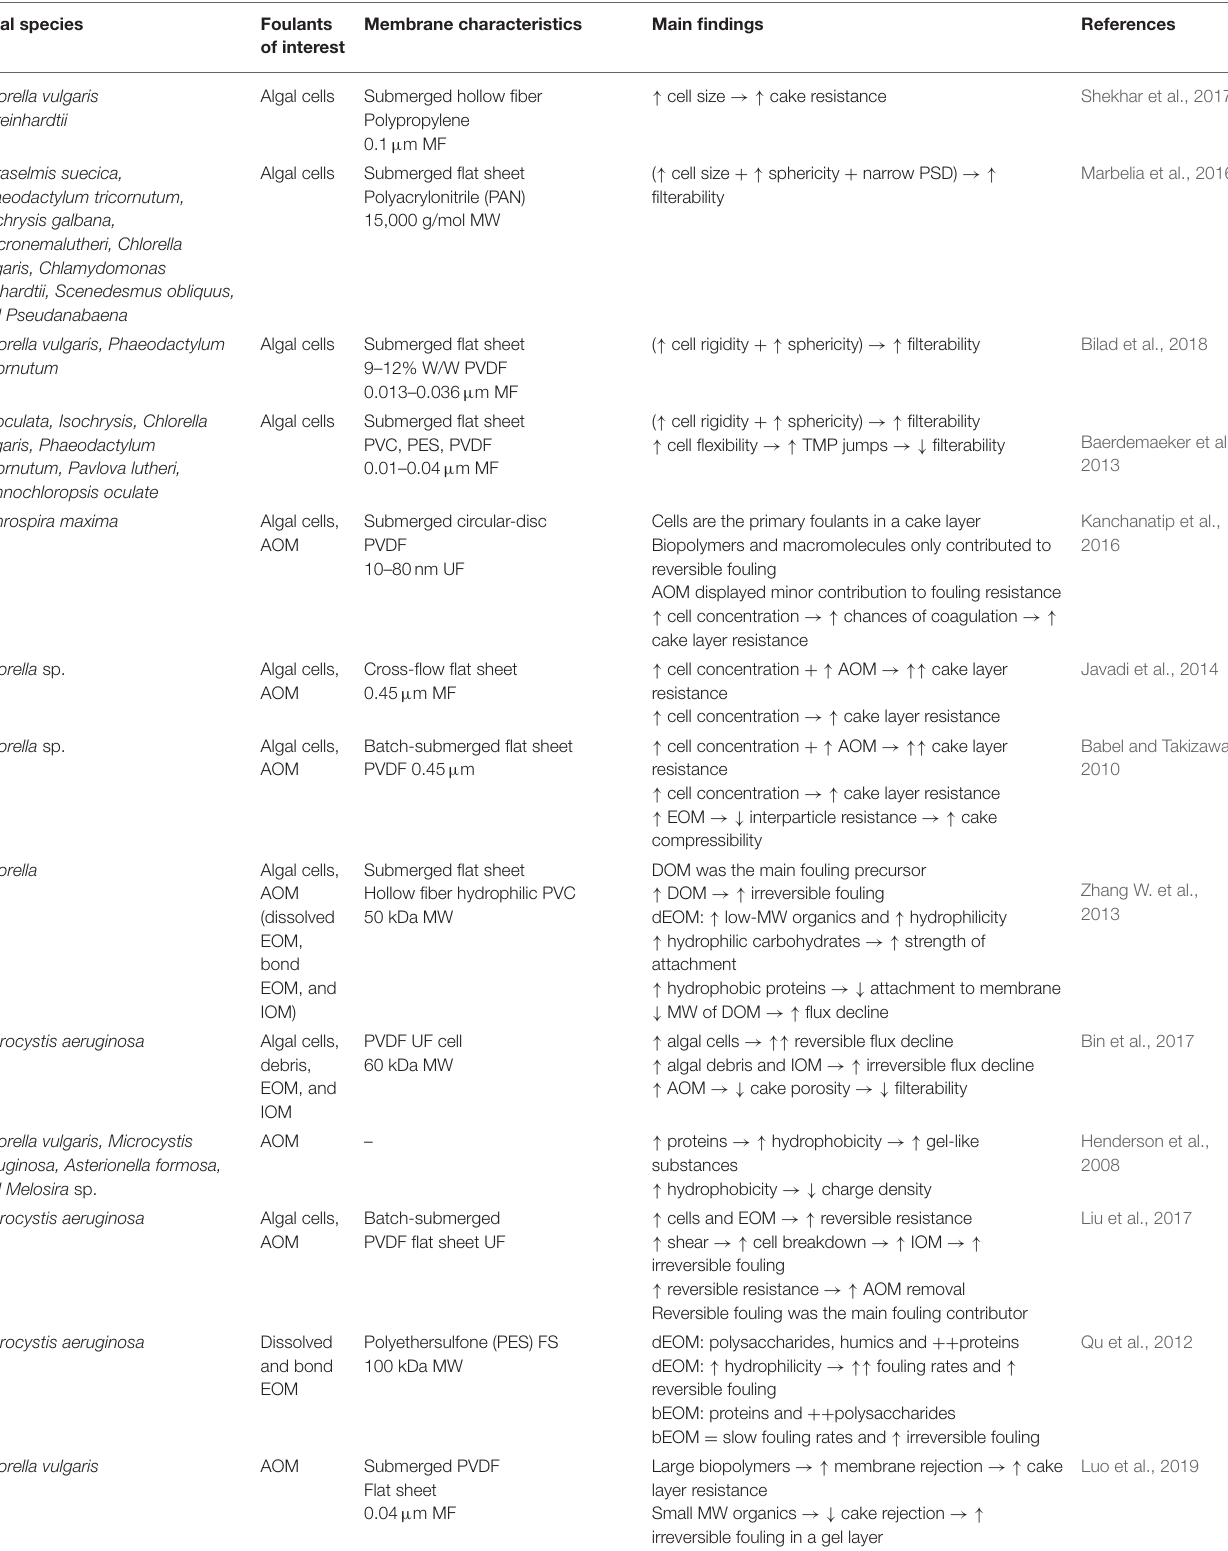
TABLE 2 | Summary of recent findings on algal fouling precursors and their effect on fouling